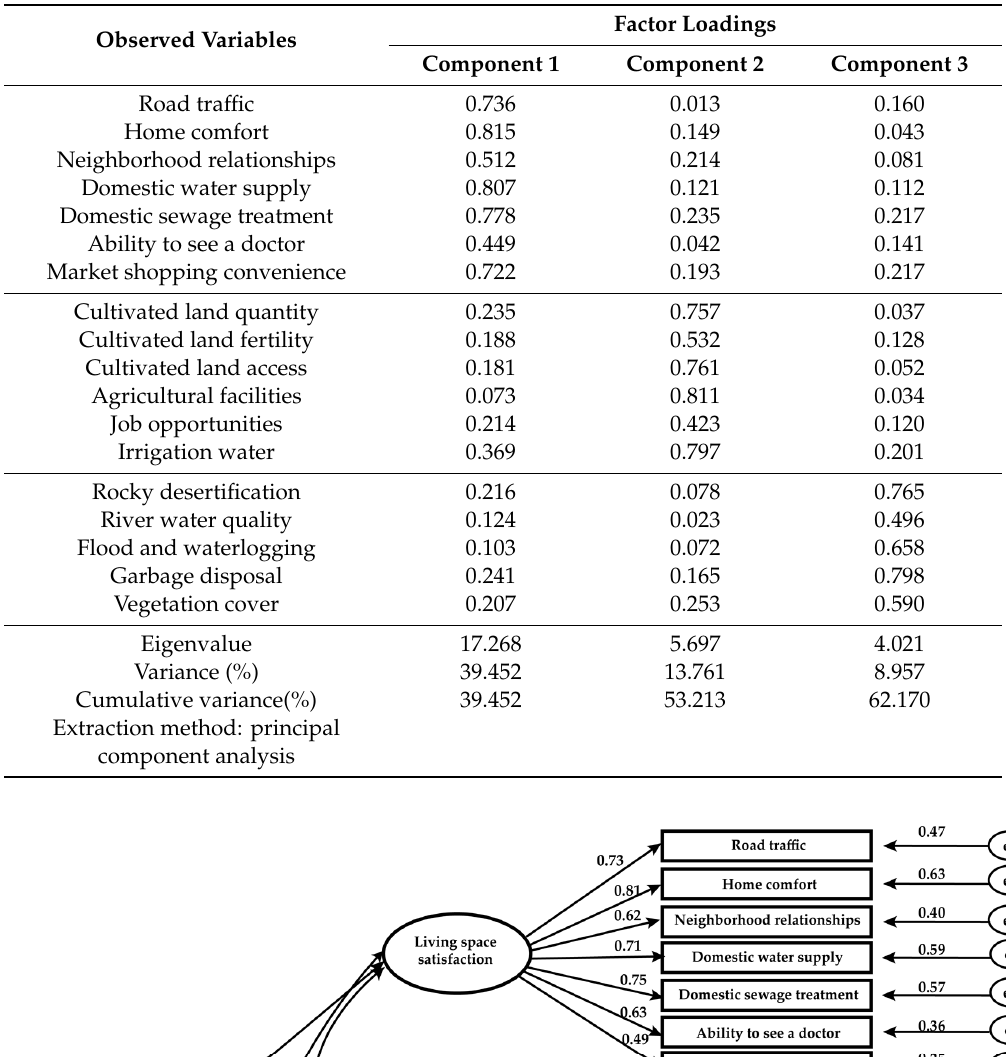
Table 5. Combined test of survey validity.